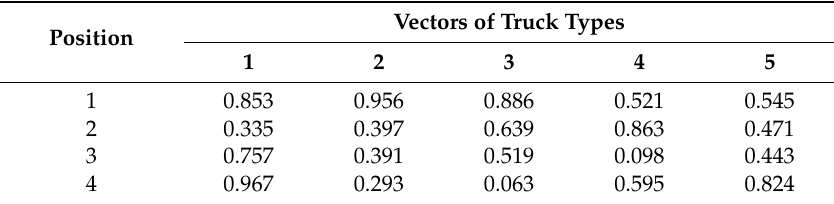
Table 1. Initial target vectors of truck types.